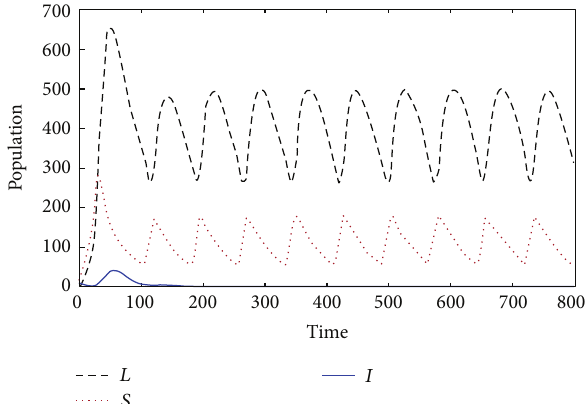
Figure 2: The case of R 0 > 1 . It is clear that, under certain parame- ter values, only larvae and susceptible population will survive while the infected population will be extinct. All parameter values are the same except 𝛽 = 0.208 .